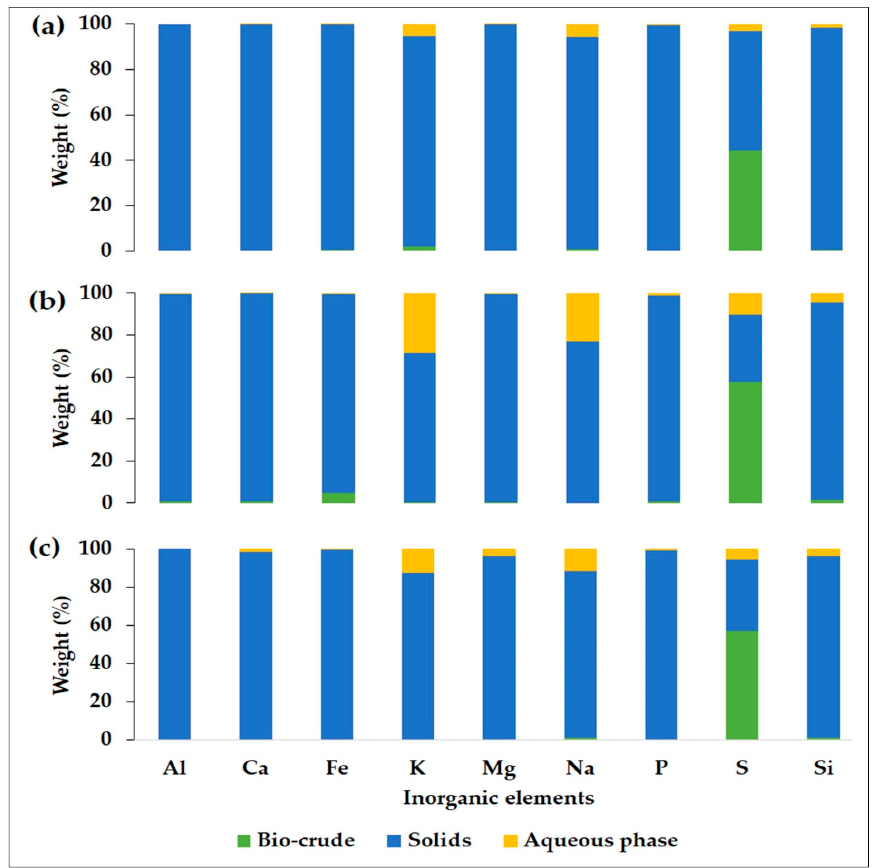
Figure 11. Distribution of inorganic elements at ( a ) C0, ( b ) C5, and ( c ) Cat-acetic acid.